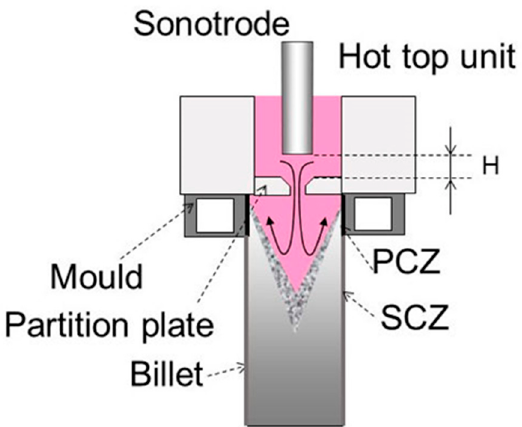
Figure 3. A schematic representation of flow-restricting hot-top for ultrasonic treatment.